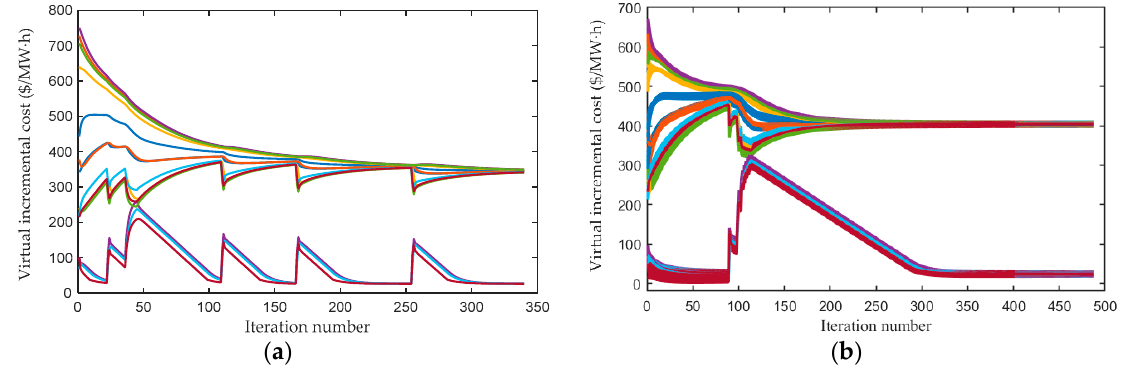
Figure 11. Convergence process of ACA under scenario #3. ( a ) 12 agents; ( b ) 600 agents.